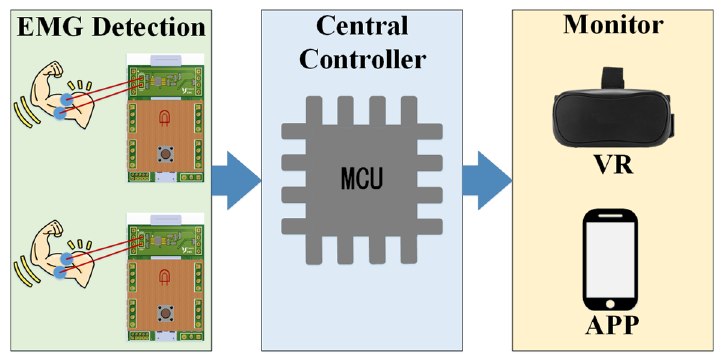
Figure 2. Hardware architecture of the smart wearable biomedical sensing system.